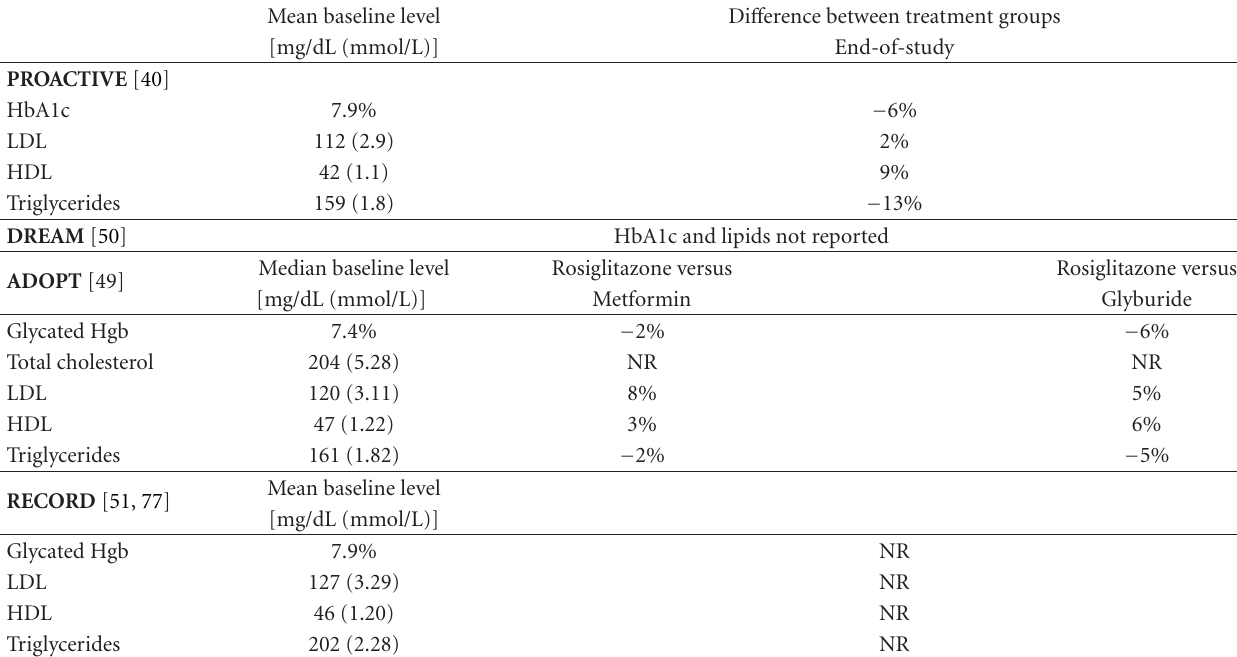
Table 4: Selected laboratory data from endpoint trials of PPAR- γ